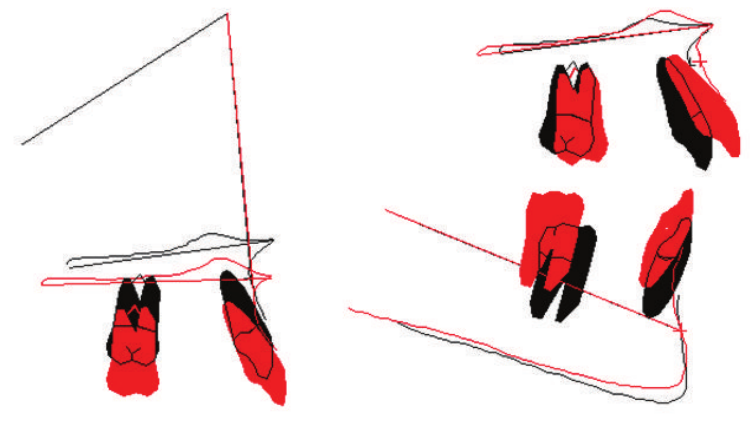
Figure 10: Superimpositions of the upper and lower dental arches before (black) and after (red) treatment.